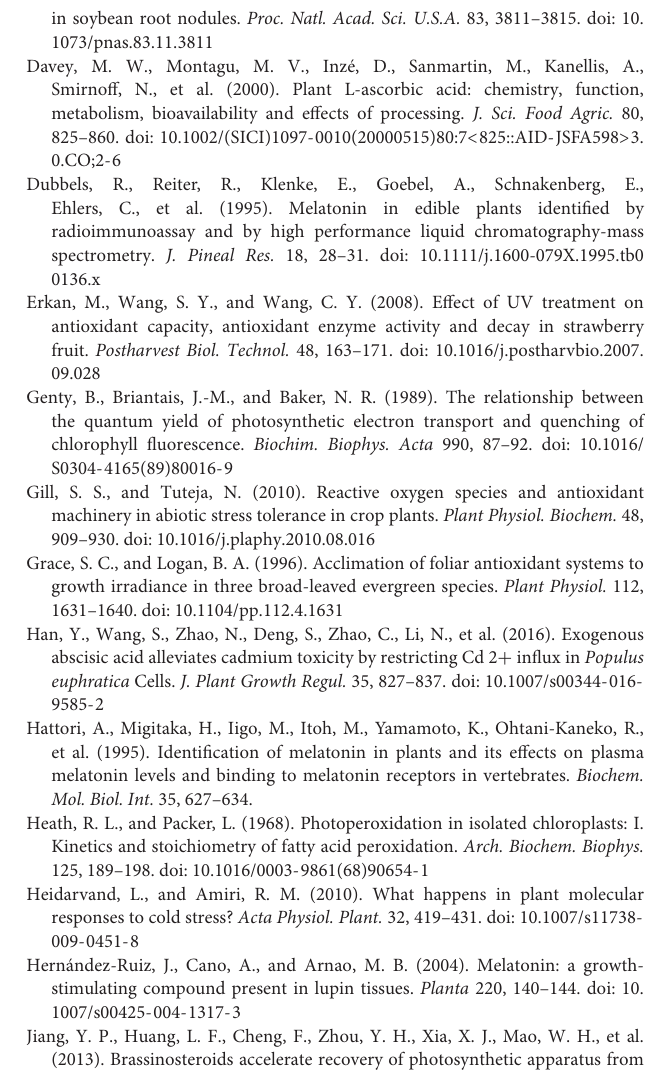
FIGURE S1 | Effects of exogenous melatonin on superoxide dismutase (SOD) activity in chloroplast under chilling stress. Control (28/18 ◦ C); Control + Melatonin (200 µ M melatonin, 28/18 ◦ C); Chilling (15/8 ◦ C); Chilling + Melatonin (200 µ M melatonin, 15/8 ◦ C). Data are means ± SD of three